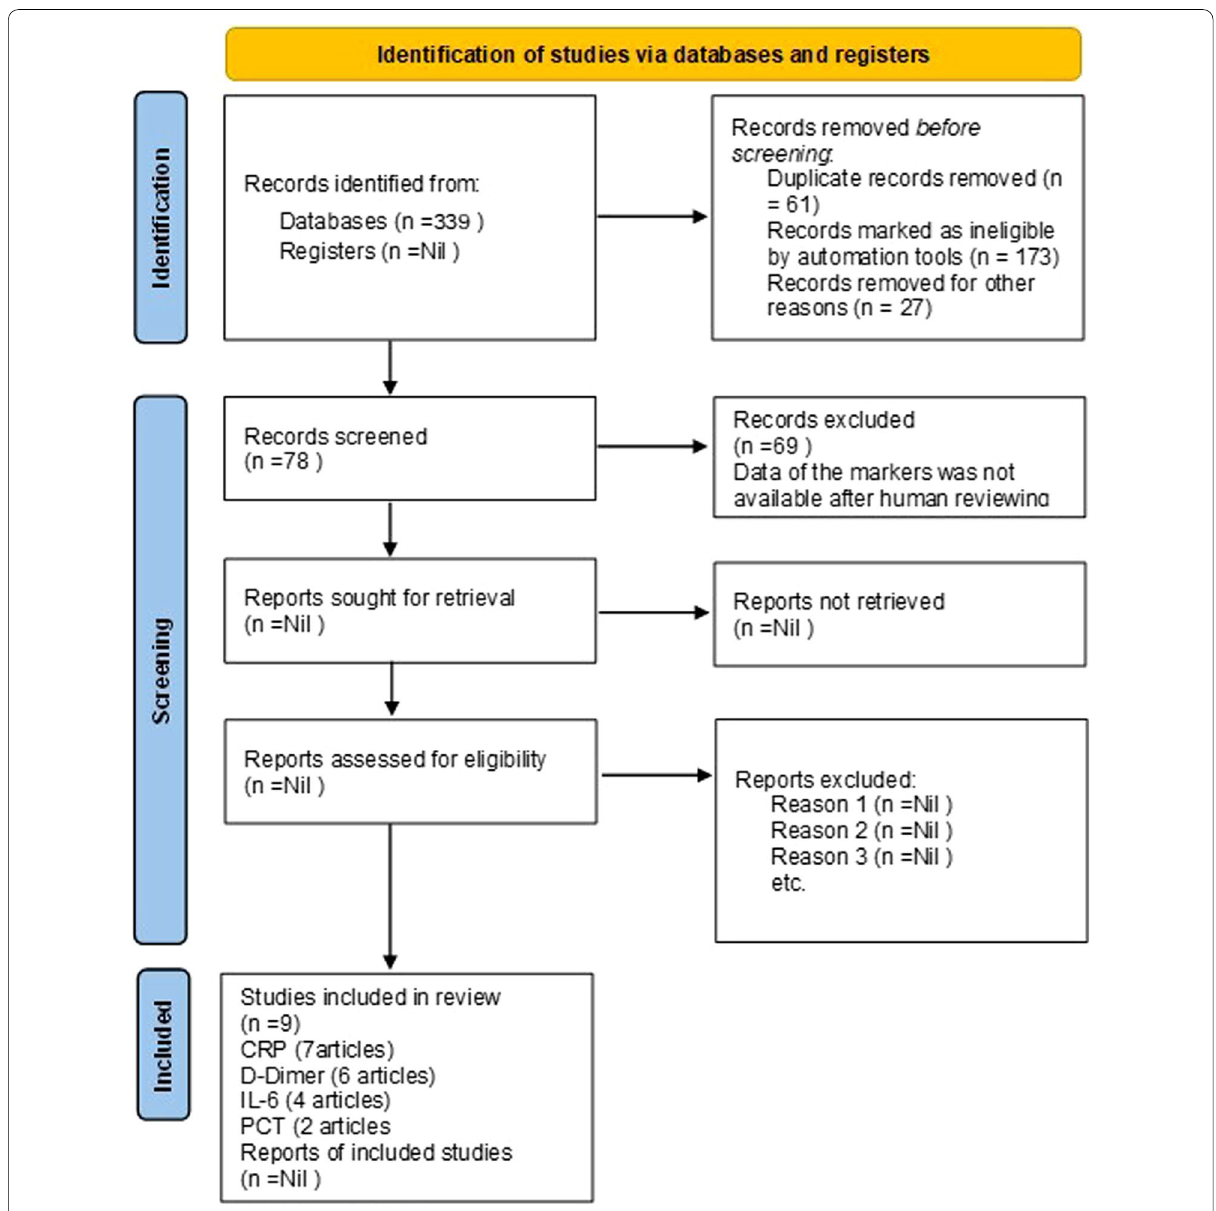
Fig. 1 PRISMA flow diagram for systematic review which included searches of